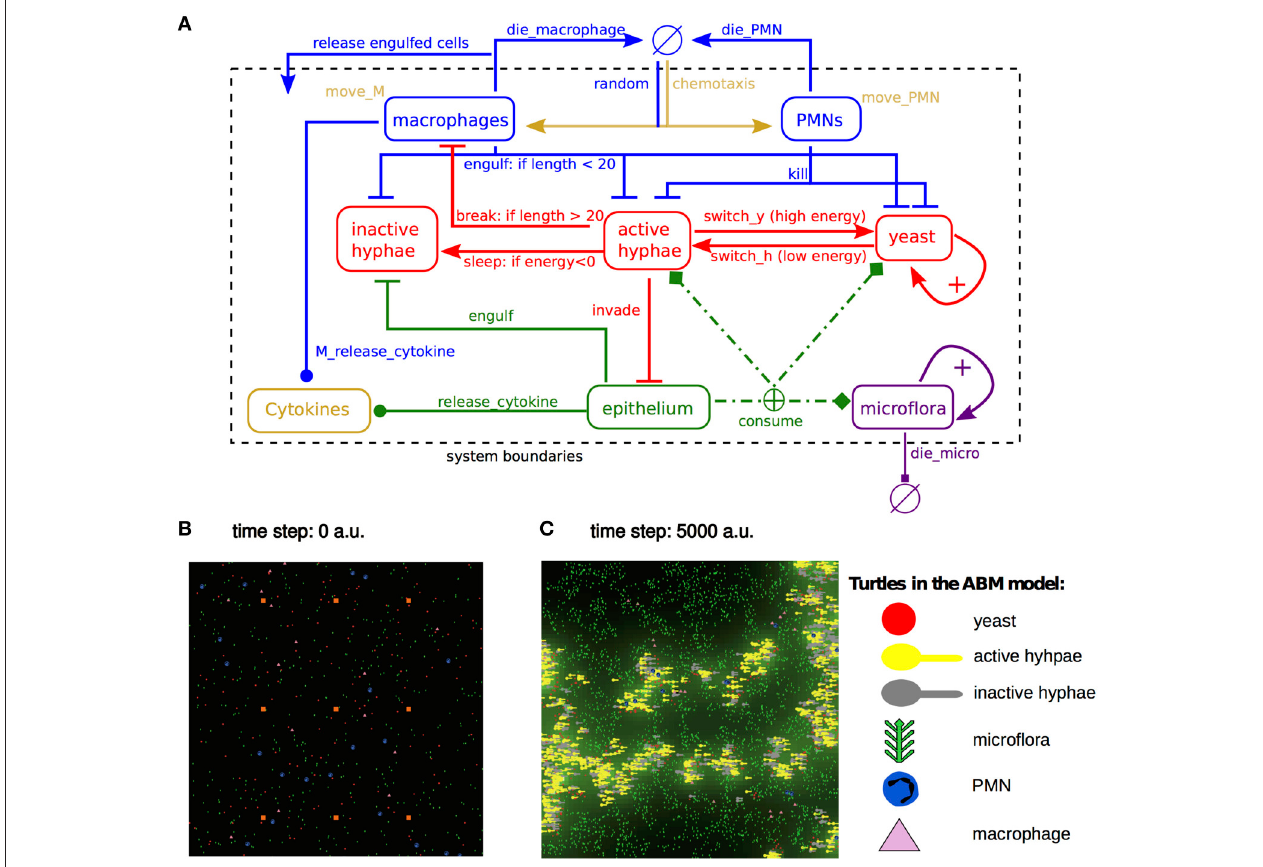
FIGURE 1 | Model description and framework. (A) Graphical representation of the model implemented in NetLogo. Arrows indicate transitions from one agent type to another, barred lines indicate negative interactions, lines ending in circles indicate positive interactions. (B,C) Snapshots of the model at t = 0 ts and t = 5000 ts . Portals , (orange squares), provide an access for the phagocyte entering the system from the bloodstream. Agents (yeast: red; active hyphae: yellow; inactive hyphae: gray; microflora: green; PMNs: blue; macrophages: pink) are randomly spread over the world at the beginning of the simulation. At t = 5000 ts C. albicans yeast and hyphal agents as well as microflora have colonized the patches. Cytokine values are indicated by levels of green.